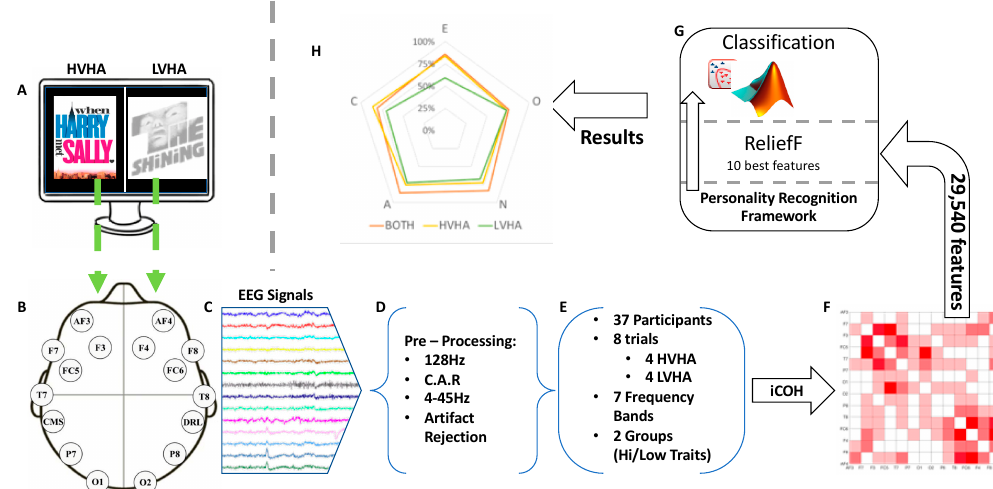
Figure 1. This figure describes the stages of our research methodology. In the beginning, high valence high arousal (HVHA) and low valence high arousal (LVHA) short videos were displayed to the participants of the AMIGOS experiment ( A ) and their affective responses were recorded using the EEG modality ( B ). Then, the EEG recordings ( C ) were pre-processed ( D ), while ( E ) shows the experimental details. The construction of brain networks using iCOH ( F ) followed next and the extraction of features based on the network’s weights as well as on graph theoretical properties was performed. ReliefF ( G ) concluded on the 10 best features per trait, and was used three times; the first time, for sorting the features extracted during HVHA block of clips; the second time, for sorting the features extracted during LVHA block of clips; and one more time, for sorting all the aforementioned features together (BOTH). Finally, the classification stage ( H ) yields the presented prediction accuracy for each one of the five dimensions of personality (neuroticism (N): 83.8%, extraversion (E): 83.8%, openness (O): 73%, agreeableness (A): 86.5%, and conscientiousness (C): 83.8%). EEG, electroencephalographic; iCOH, imaginary part of coherence.